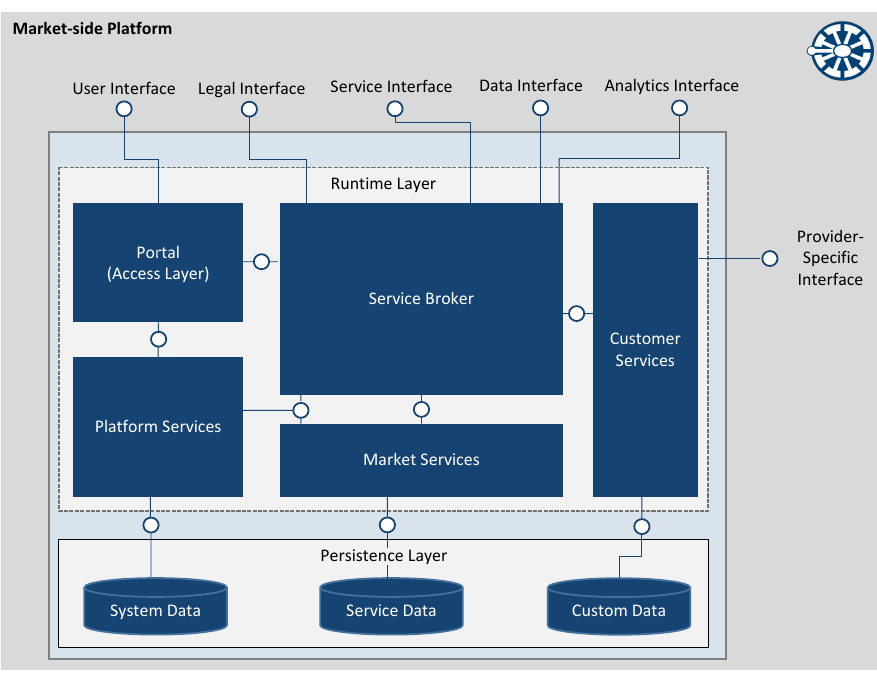
Figure 4. Architecture of the Market-side